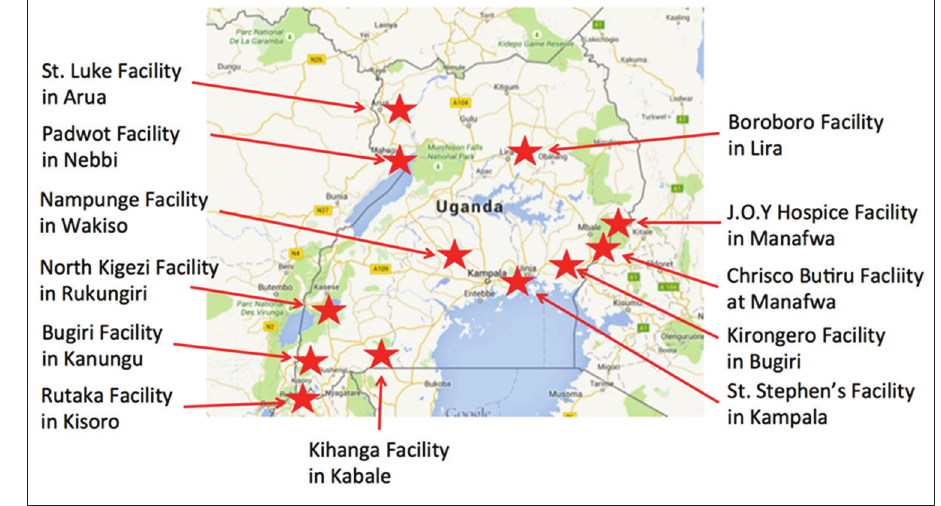
Figure 1 : Location of 12 clinics where ultrasound machines were donated and midwives were recruited and